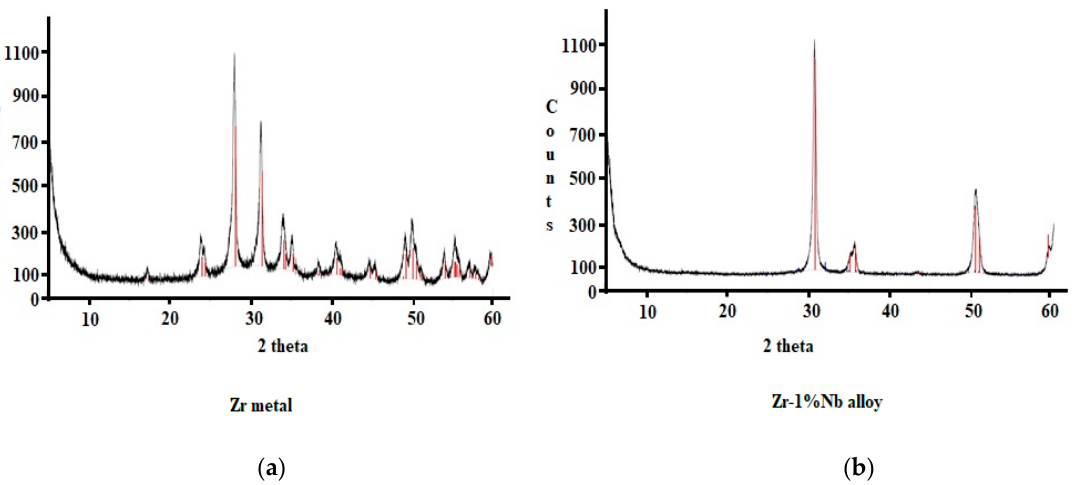
Figure 1. X-ray diffraction spectra of ( a ) Zr metal and ( b ) Zr-1%Nb alloy at room temperature.